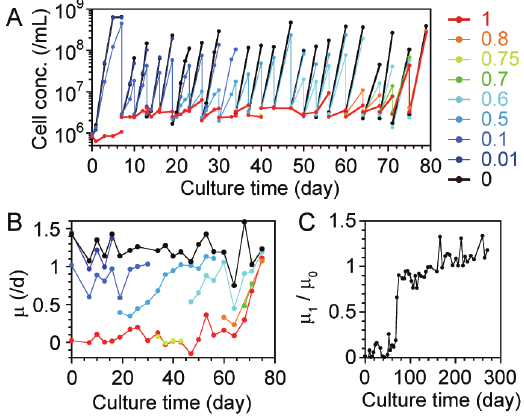
Figure 1. Evolutionary changes during adaptation to a nutrient-rich environment. We cultivated the cells in media with various concentrations of toxic amino acids until culture day 79, then used only TCM1 and TCM0. (A) Population dynamics in the evolution experiment until day 79. The colors show the culture media used (TCM x media; x is shown on the right). The transfers of the culture by dilution are depicted as the vertical decrease in the cell concentration. (B) Evolutionary changes in the specific growth rate ( m ) in media with different toxic amino acid concentrations (the colors are same as in A). The specific growth rate was determined by the slope of the linear regression of the natural log of cell concentration per day, using first three (or two, if only two points were measured in the culture) data points. (C) The evolutionary changes in the relative specific growth rates of the cells in TCM1 ( m 1 ) and in TCM0 ( m 0 ). The raw data of the population dynamics are shown in Figure S4 in File S1.